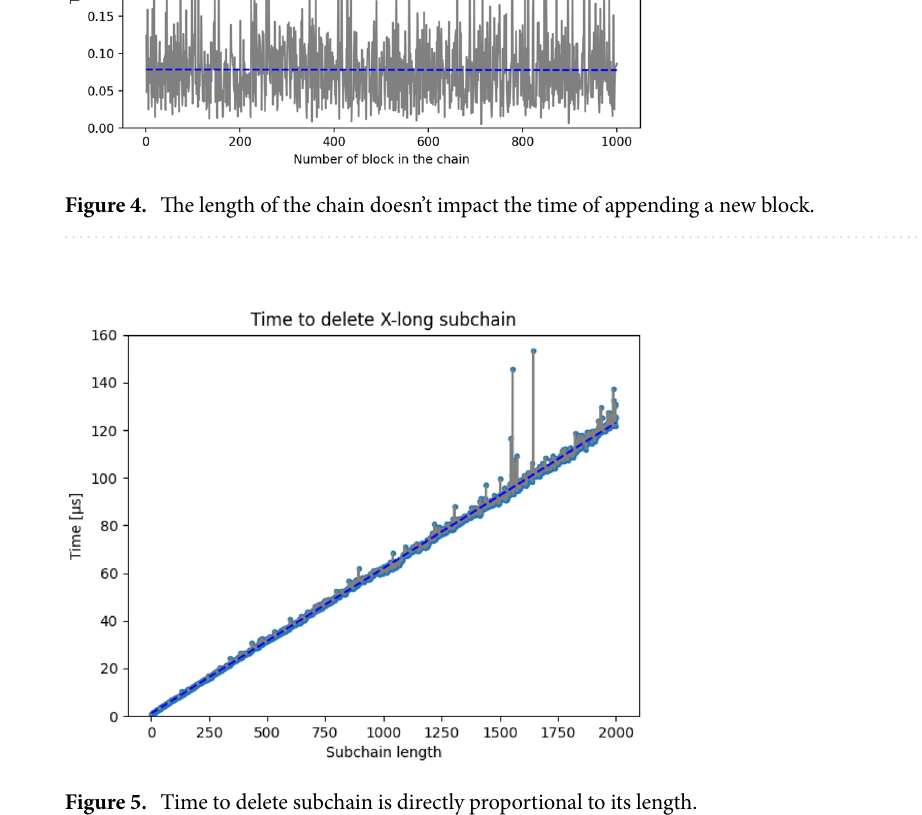
Figure 5. Time to delete subchain is directly proportional to its